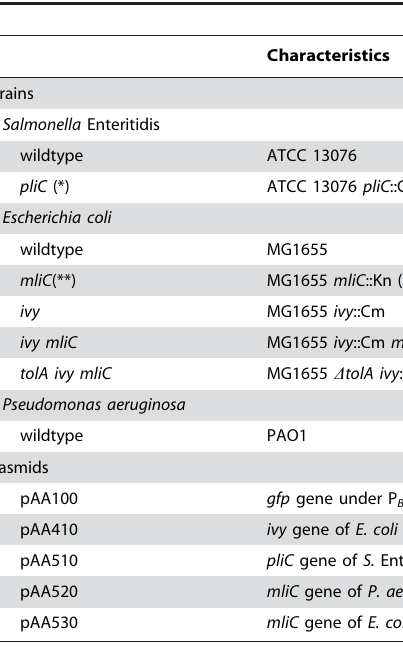
Table 1. Bacterial strains and plasmids used in this